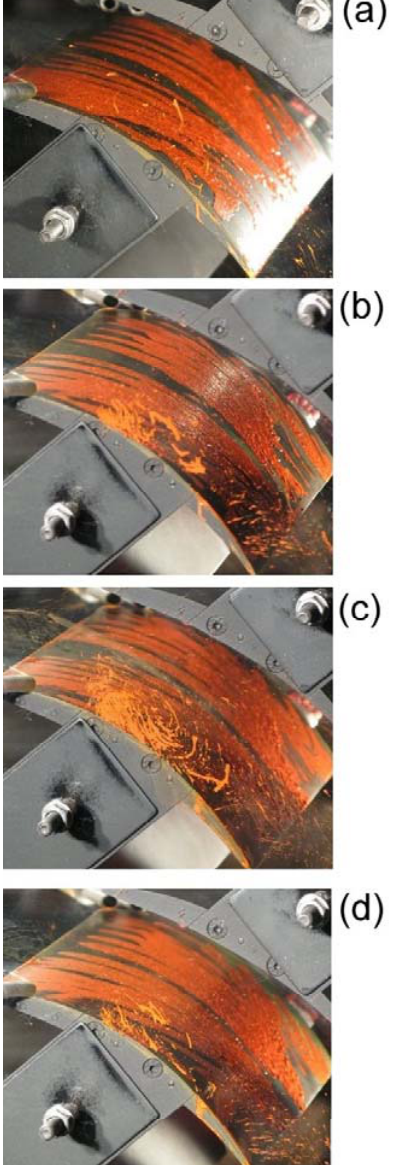
Fig. 6. Surface visualization for i = 8.3°, for various control jets: (a) no control, (b) steady control jets at c u = 1.39, (c) pulsatile control jets at f = 20 Hz, c u = 0.93, (d) pulsatile control jets at f = 20 Hz, c u =